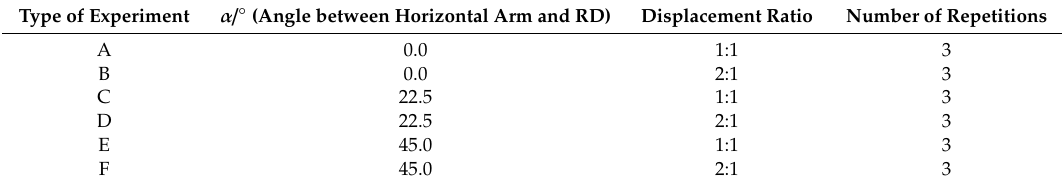
Table 4. Experimental